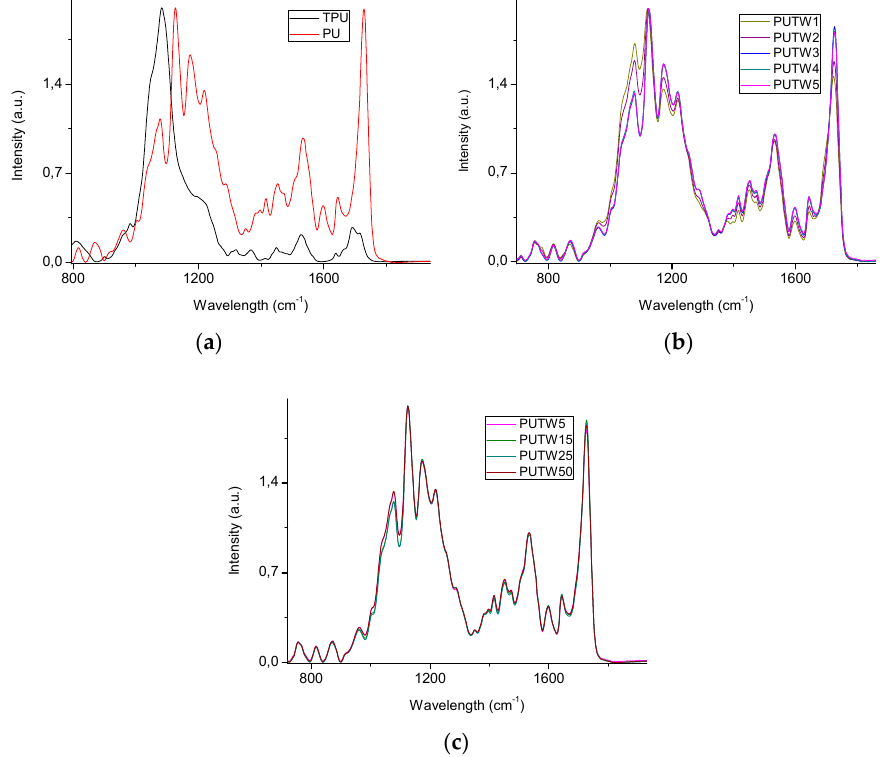
Figure 5. FTIR spectra of ( a ) PU foams and thermoplastic polyurethane (TPU), ( b ) PUT samples after 1 (PUTW1), 2 (PUTW2), 3 (PUTW3), 4 (PUTW4), and 5 (PUTW5) washing cycles), and ( c ) PUT samples after 5, 15 (PUTW15), 25 (PUTW20), and 50 (PUTW50) washing cycles. Full spectra can be found in the Supplementary Materials (see Figure S7).